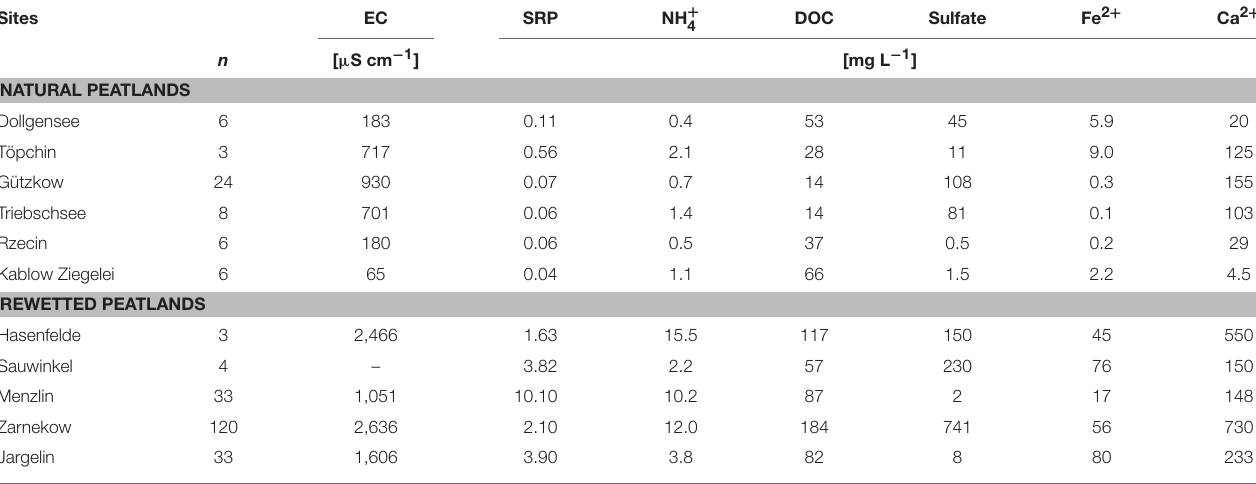
TABLE 1 | Select data on porewater chemistry (EC—electrical conductivity, SRP—soluble reactive phosphorus). Sites